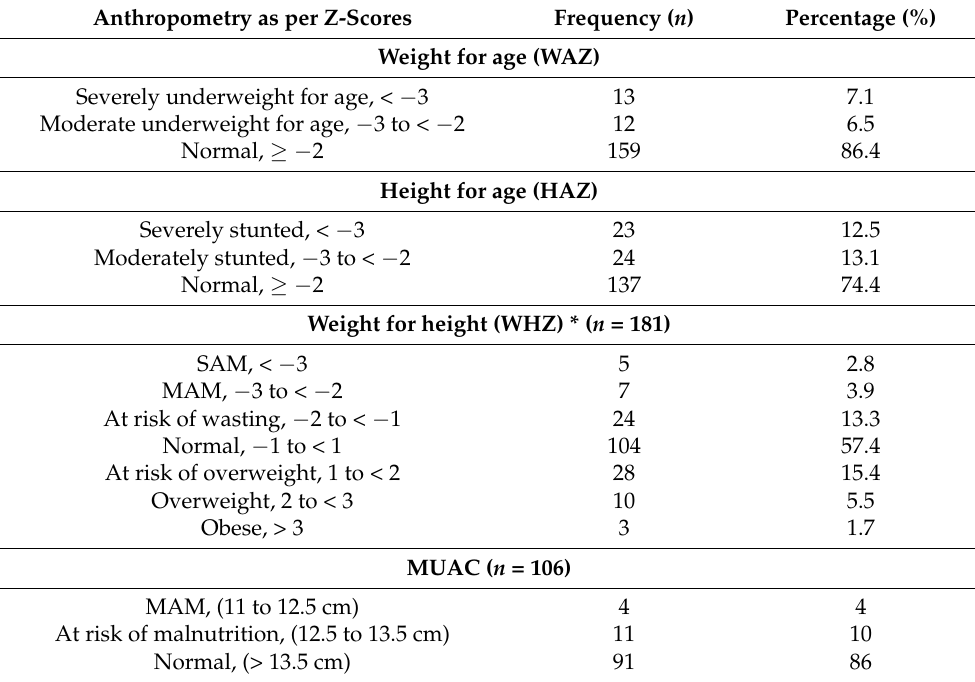
Table 5. Anthropometric classification of surveyed children ( n =